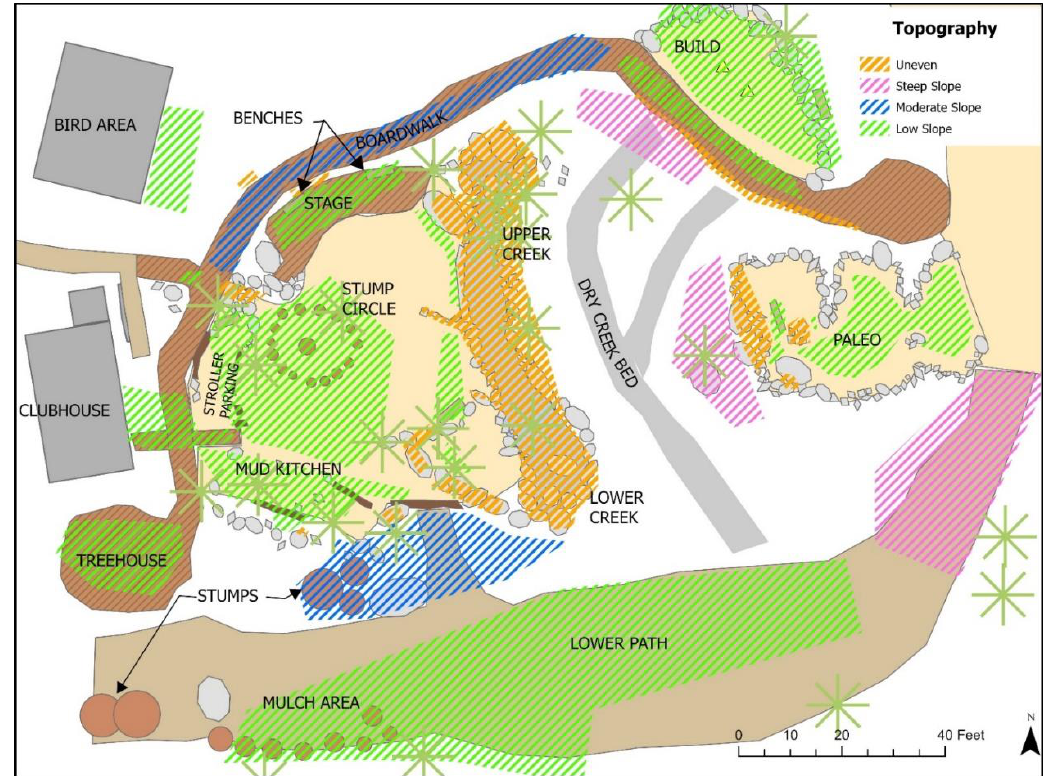
Figure 12. Topography designations for The Backyard.